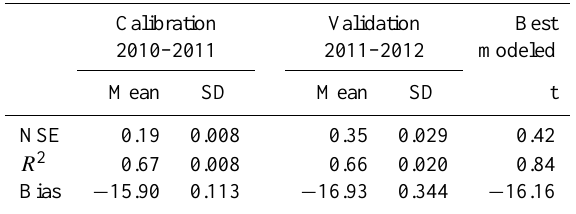
Table 5. Model performance during calibration and validation for all behavioral model runs (based on all calibration runs with based on